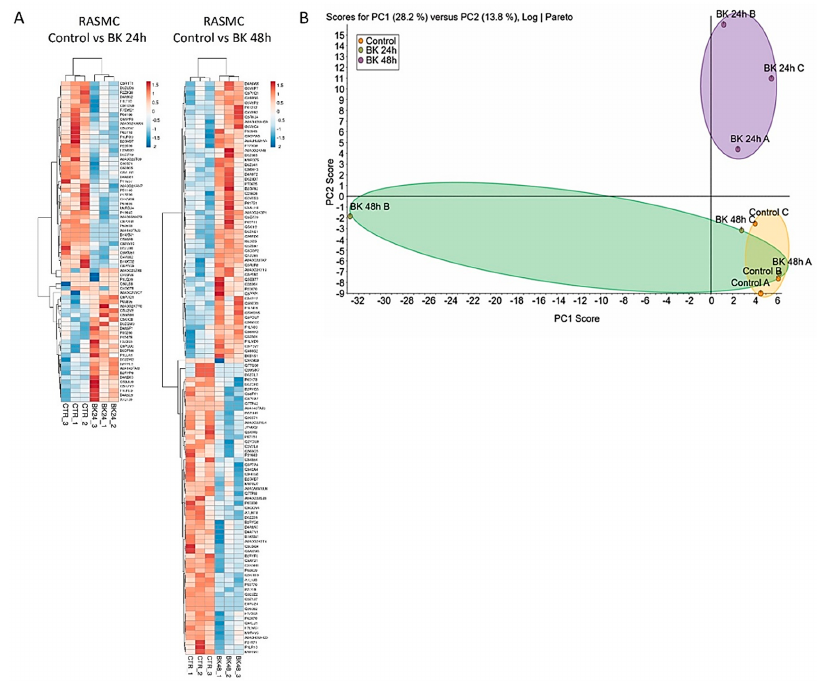
Figure 1. Characteristics of proteomic of bradykinin (BK) stimulated rat aortic smooth muscle cell (RASMC). ( A ) . Hierarchical clustering (heat maps) of protein expression profiles in the BK (24 h or 48 h) stimulated RASMC compared to control. The downregulated proteins are represented in blue, whereas the upregulated proteins are represented in red. The level of the protein regulation is reflected in the color intensity and the accession numbers of the proteins are listed to the right side of the heat maps. The dendrogram shows the clustering of the proteins and the samples with each other. ( B ) . Principal component analysis (PCA) of the BK- stimulated RASMC samples. The axis of the principal components is depicted according to the protein expression. The control samples are enclosed by the yellow oval, the BK 24 h stimulated samples are enclosed by the violet oval, and the BK 48 h stimulated samples are enclosed by the green oval.